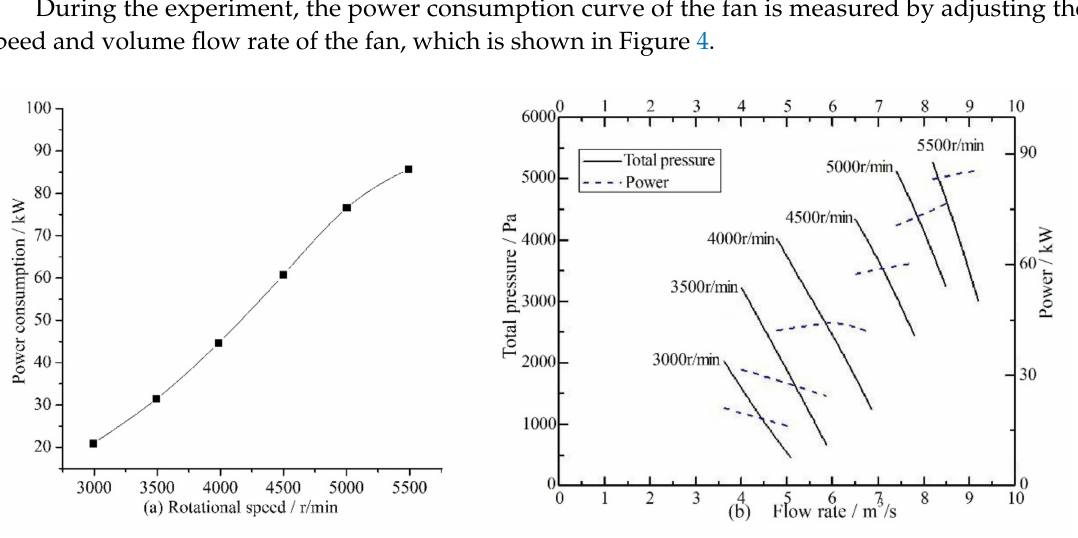
Figure 4. ( a ) Power consumption curve of centrifugal fan; ( b ) Performance characteristic curve of centrifugal